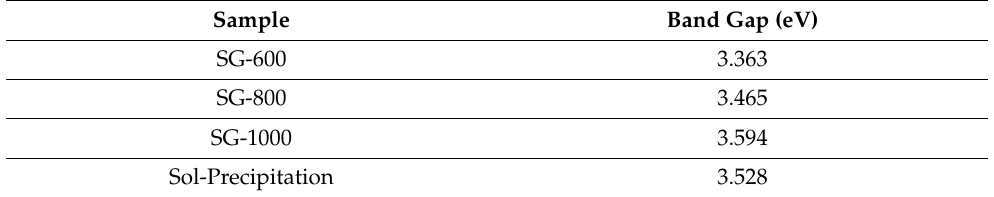
Table 3. Values found by the Tauc method for the band gap of samples obtained by the sol-gel and sol-precipitation method.